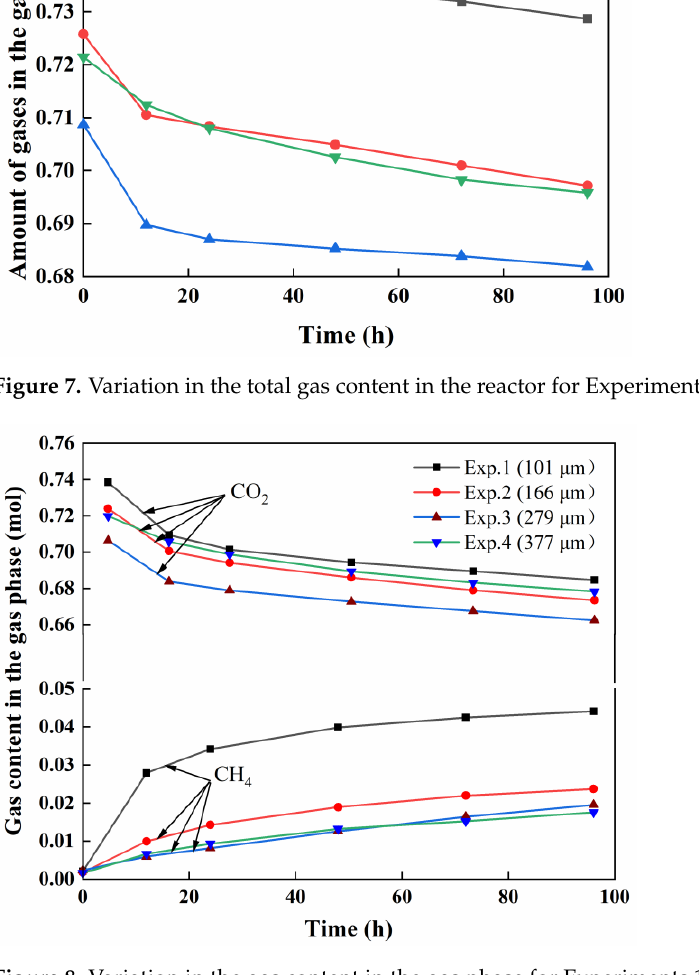
Figure 8. Variation in the gas content in the gas phase for Experiments 1, 2, 3, and